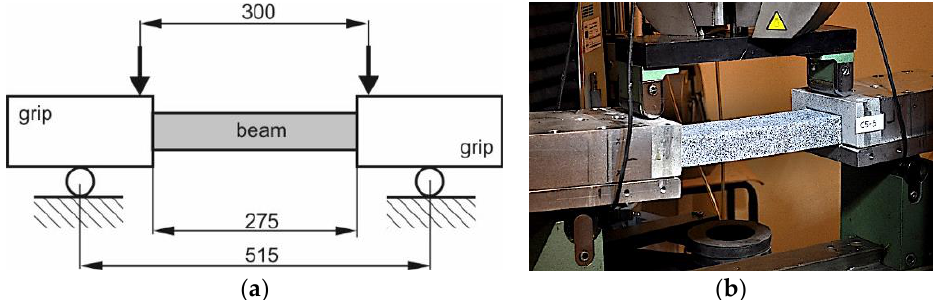
Figure 3. Scheme ( a ) and real test stand ( b ) for bending test.